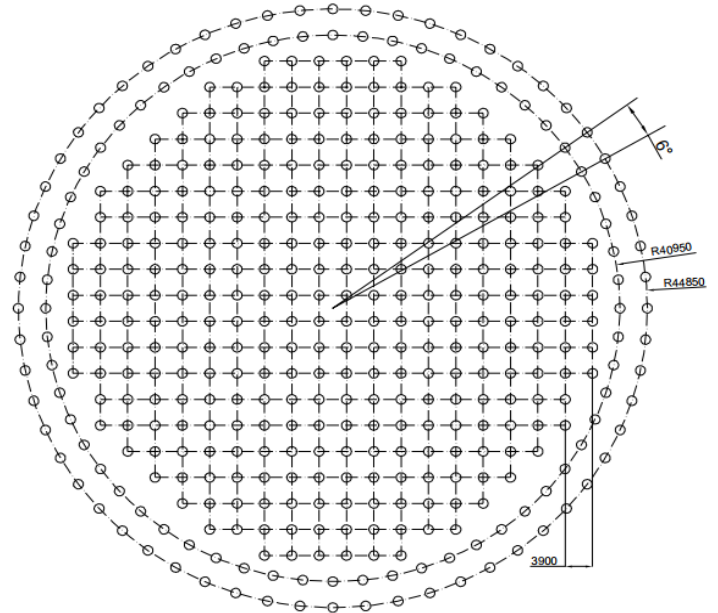
Figure 12. The layout of the pile foundation (units: mm). Table 4. Material parameters of LNG storage tank.